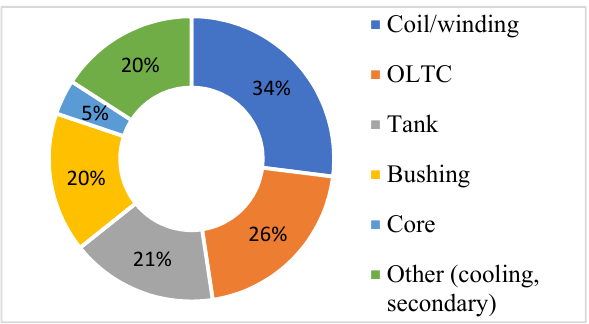
Figure 9. Common sources of transformer failures [65].